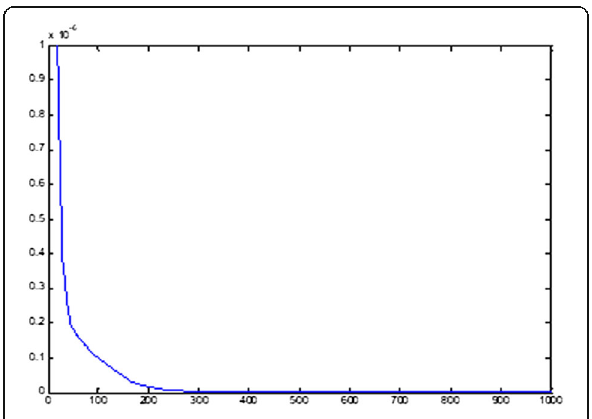
Fig. 4 Matrix eigenvalues of kernel principal component analysis (KPCA)